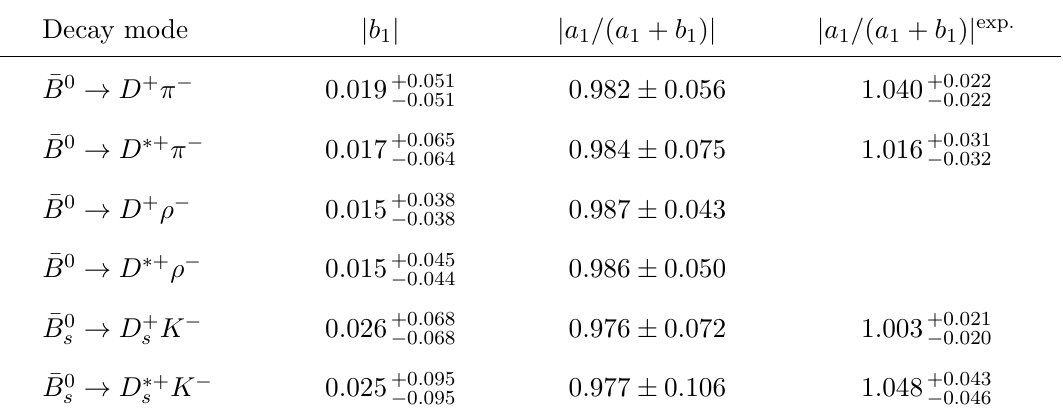
Table 4 . Our estimates of the weak annihilation coefficients | b 1 ( D ( ∗ )+ with the default values obtained by setting ρ A = 0 and the errors by varying % A and ϕ A within the intervals ρ A ∈ [0 , 2] and φ A ∈ [0 , 2 π ] respectively. The ratios | a 1 ( D ( ∗ )+ b 1 ( D ( ∗ )+ L − )) | obtained both from a direct estimate within the QCDF framework and by following ( s ) the method proposed in ref. [37] are also shown in the third and the last column,